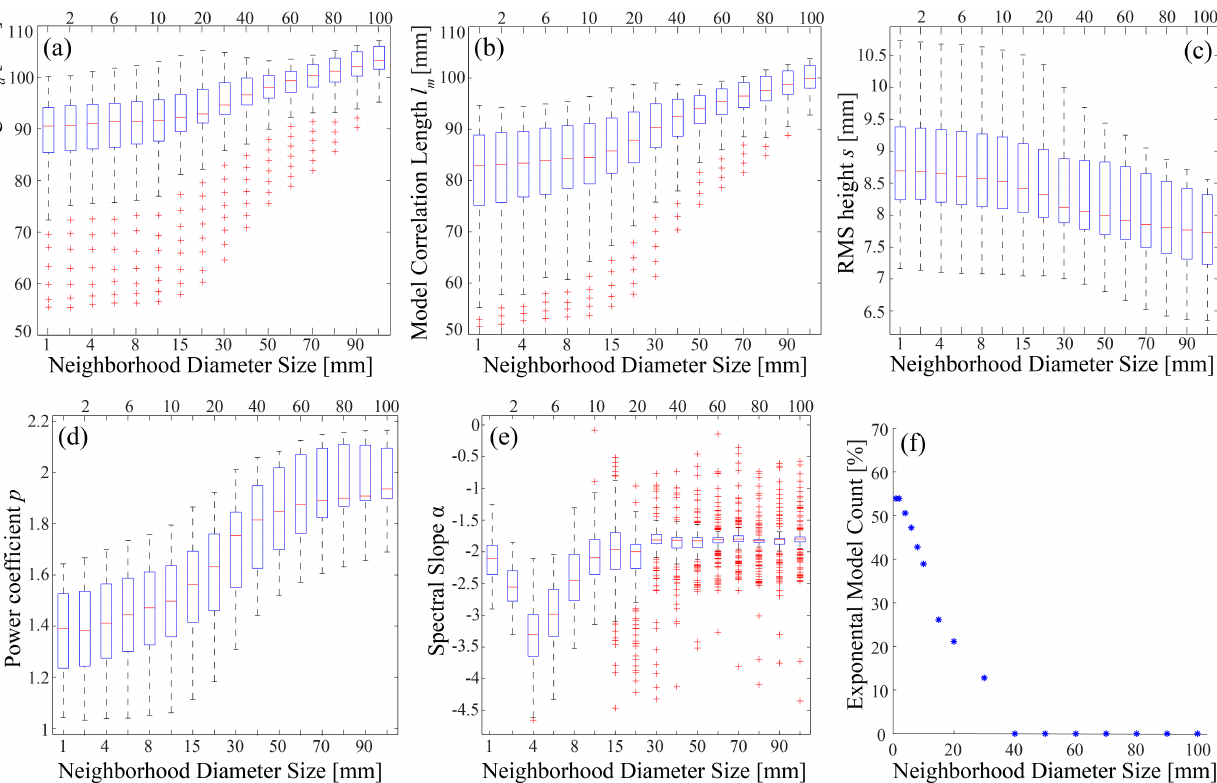
, l , s , p and α as a function of the neighborhood d m